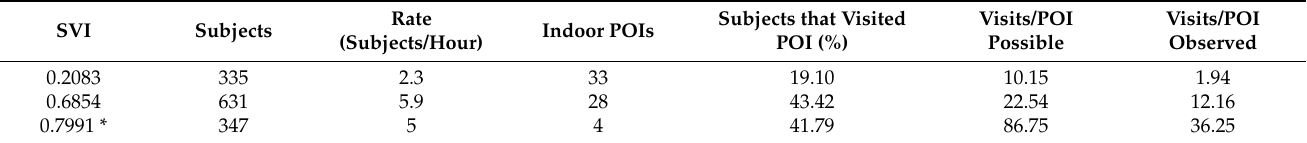
Table 5. Observations of people visiting an indoor POI location after leaving each of the three selected health facilities, during the DETER observation period of 22 March to 17 May 2020.